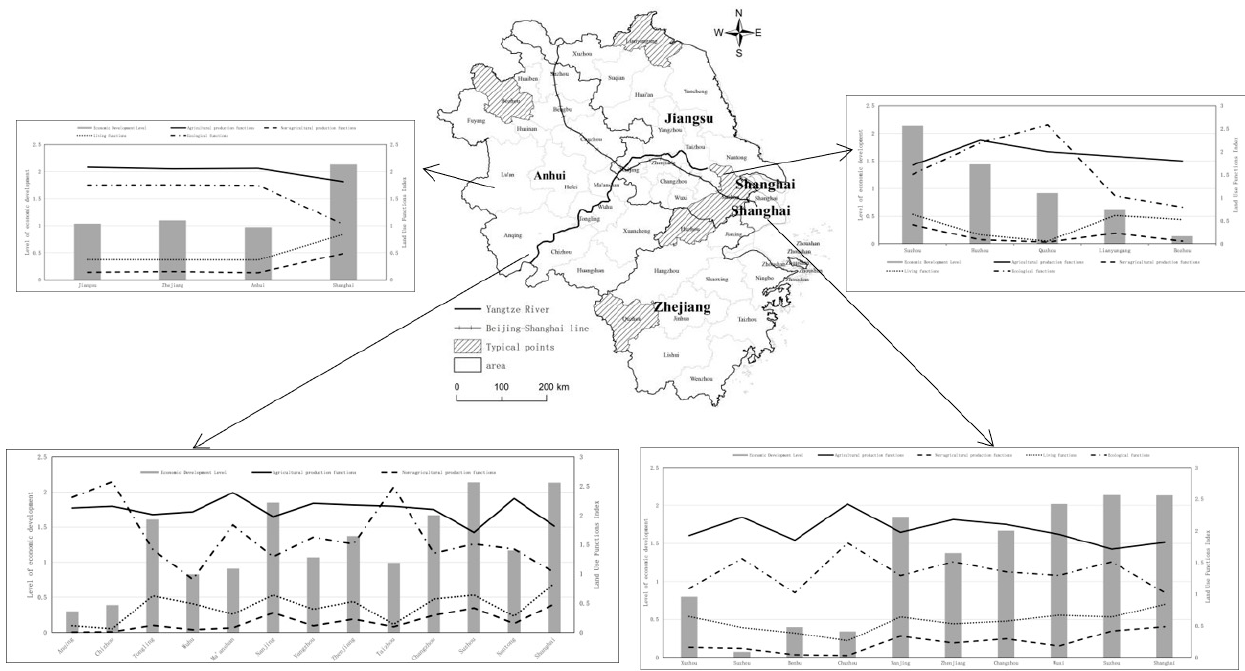
Figure 9. Distribution of land use function indices for different levels of economic development in the Yangtze River Delta region.